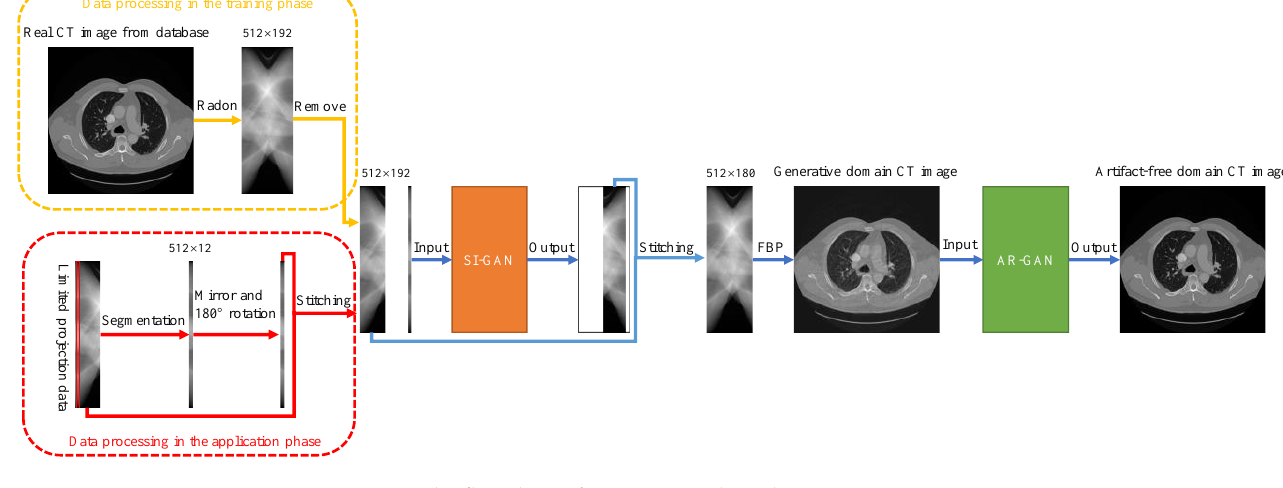
Figure 1. The flowchart of SIAR-GAN algorithm.